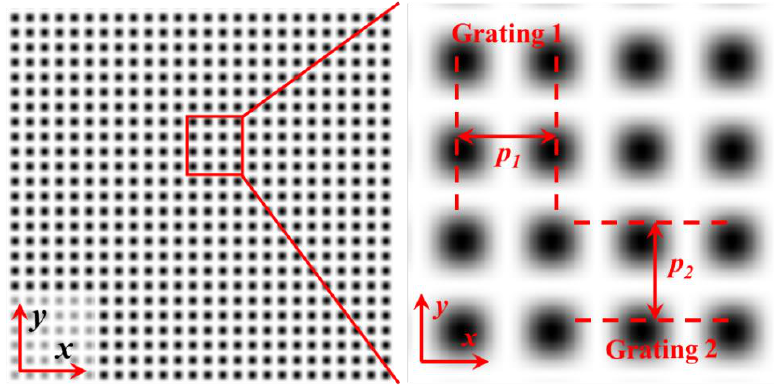
Figure 1. Orthogonal grid lines composed of two groups of vertical grid lines.